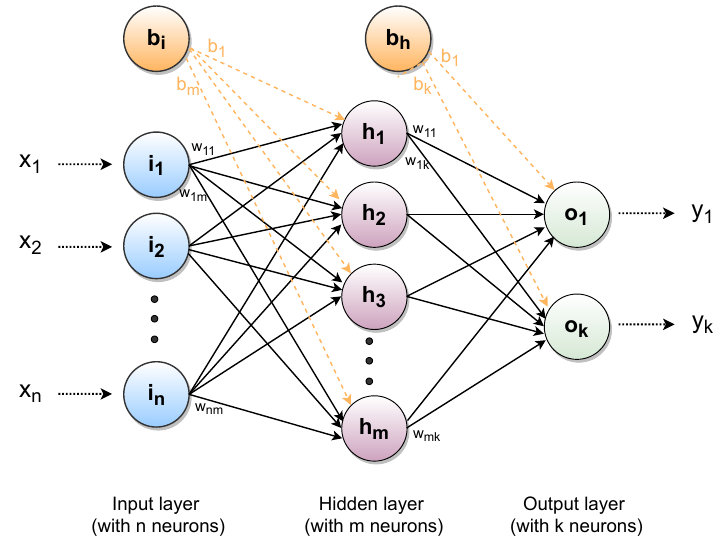
Figure 4. The standard artificial neural network